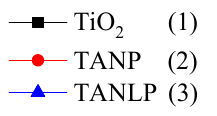
Figure 6. The I-V characteristics of TiO 2 , TANP, and TANLP in dark conditions.